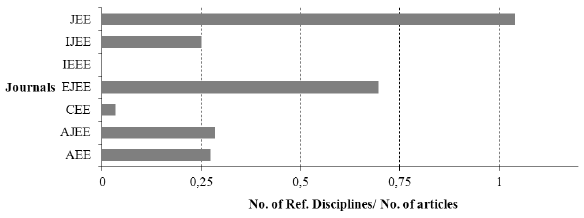
TABLE II. Nº REFERENCE DISCIPLINES PER